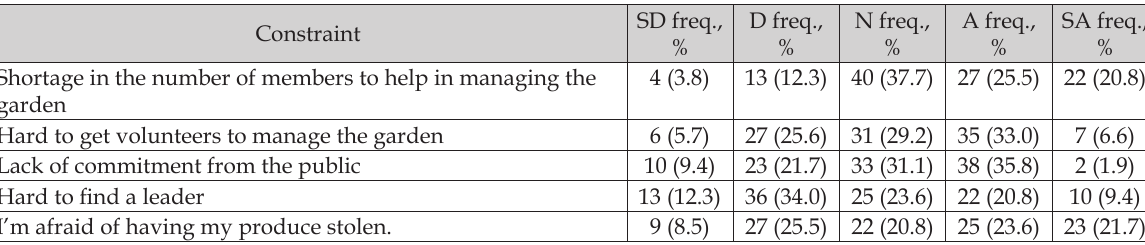
Table 7. Social constraints.